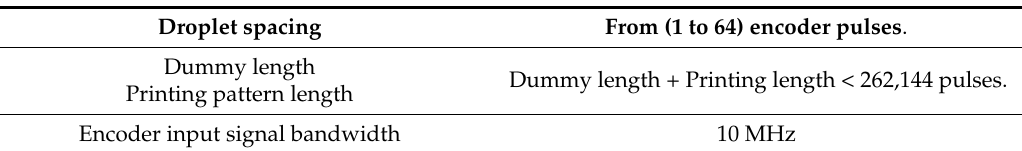
Table 1. EPU specification.